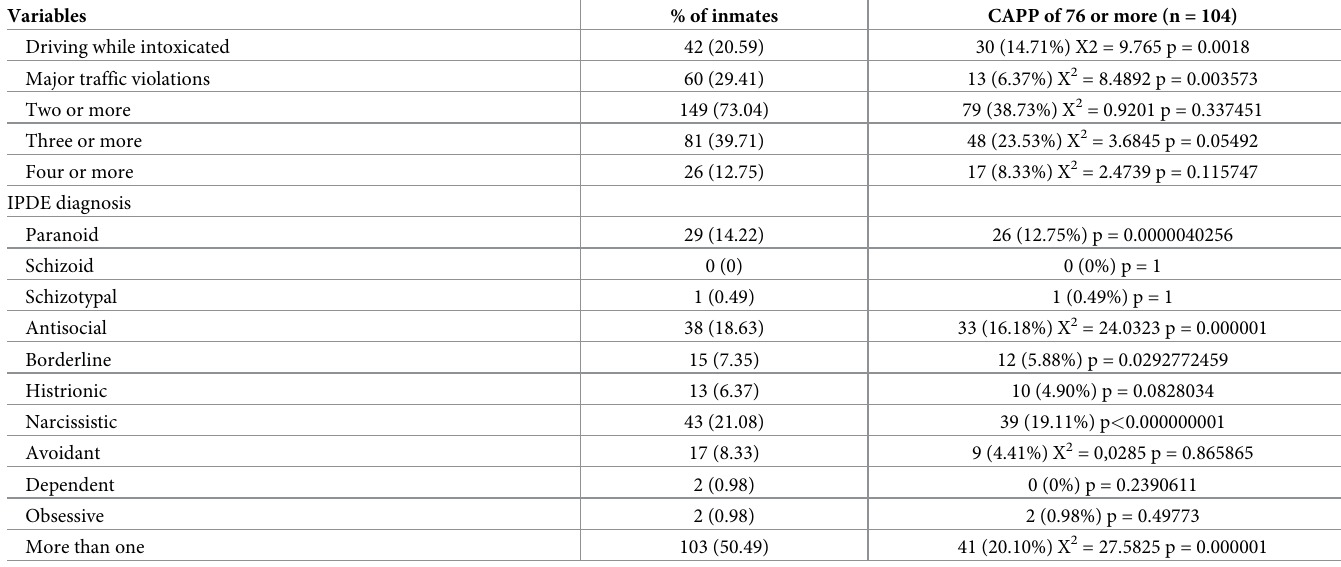
Table 2 shows the distribution of CAPP total, dimension and item scores. Table 2 also pres- ents Cronbach’s alpha scores for the CAPP. Internal consistency was excellent for all domains and for total score. Table 3 shows reliability indexes from Classical Test Theory (CTC) as mean inter-item cor- relation and corrected-item total correlation. These index ´results were also excellent for all CAPP domains and total score. For the CAPP regression analysis model, the following variables were significant at an alpha level of 5% for the whole sample: IPDE paranoid (F = 32.16, p < 0.0001), IPDE antisocial (F = Table 4 shows correlations among CAPP (Total and Domain scores) for the whole sample. The lowest correlation was between attachment and behavioural (0.55), and the highest between dominance and emotional (0.91). Actually, behavioural showed the lowest correlation not only with attachment but also with dominance (0.63), emotional (0.61), and self (0.59). Therefore, behavioural was the domain with the lowest correlations of all, and the correlation between the other domains scored higher than 0.65. Confirmatory factor analysis (CFA) was applied to CAPP scores using the Lavaan package [34] of the R statistical software. Weighted least-squares and maximum-likelihood estimation were used. The following exploratory models were compared: All dimensions, without cogni- tive, without behavioural, without behavioural and cognitive, without behavioural & cognitive & emotional, and without behavioural & cognitive& emotional & dominance, and a three-fac- tor model (attachment and emotional versus behavioural and cognitive versus dominance and self). None of the fits can be considered to correspond to a good model (Table 5). Next, exploratory bi-factor models were evaluated, showing best fit for one general PPD factor and between 3 oblique bi-factors in keeping with previous research [30]. Table 5 also presents the model fit statistics associated with these models, and Table 6 shows the Fully Stan- dardized Factor Loadings for Bi-Factor EFA